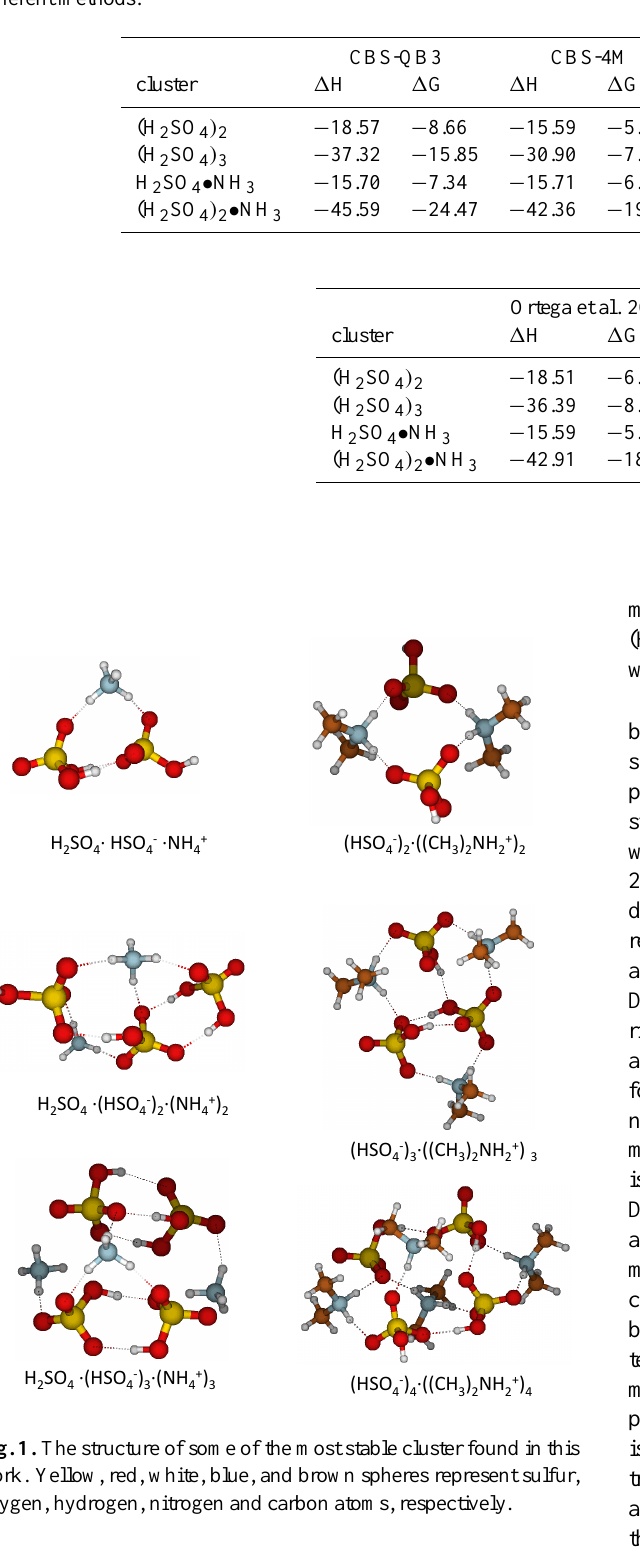
Table 2. Gibbs free energies and enthalpies of formation in kcalmol − 1 for selected sulfuric acid and ammonia clusters obtained with different methods.